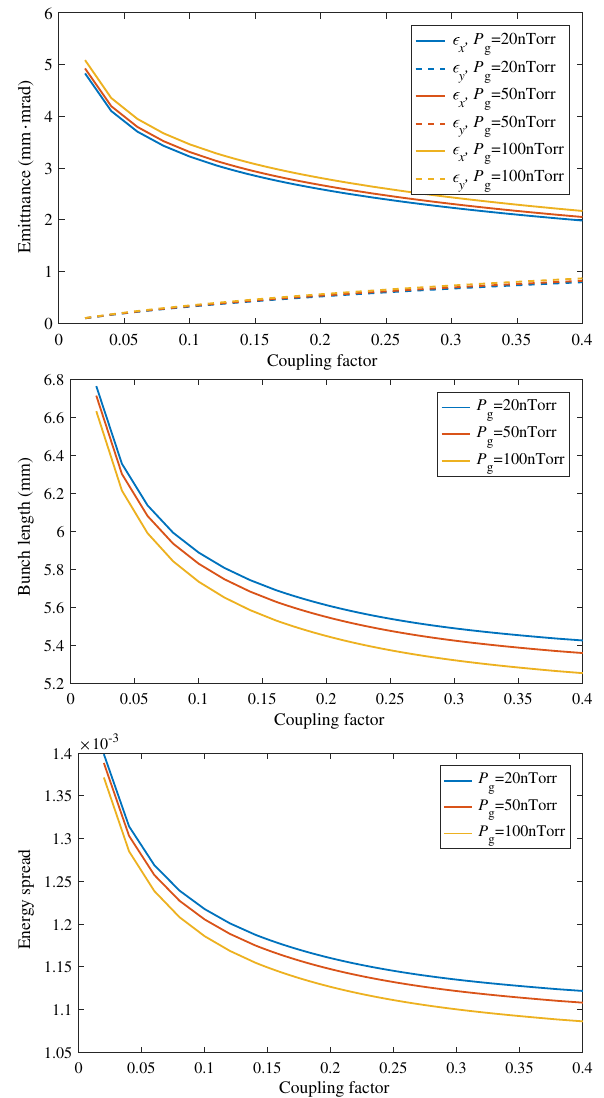
FIG. 21. Equilibrium parameters with varying gas pressure and coupling factor.